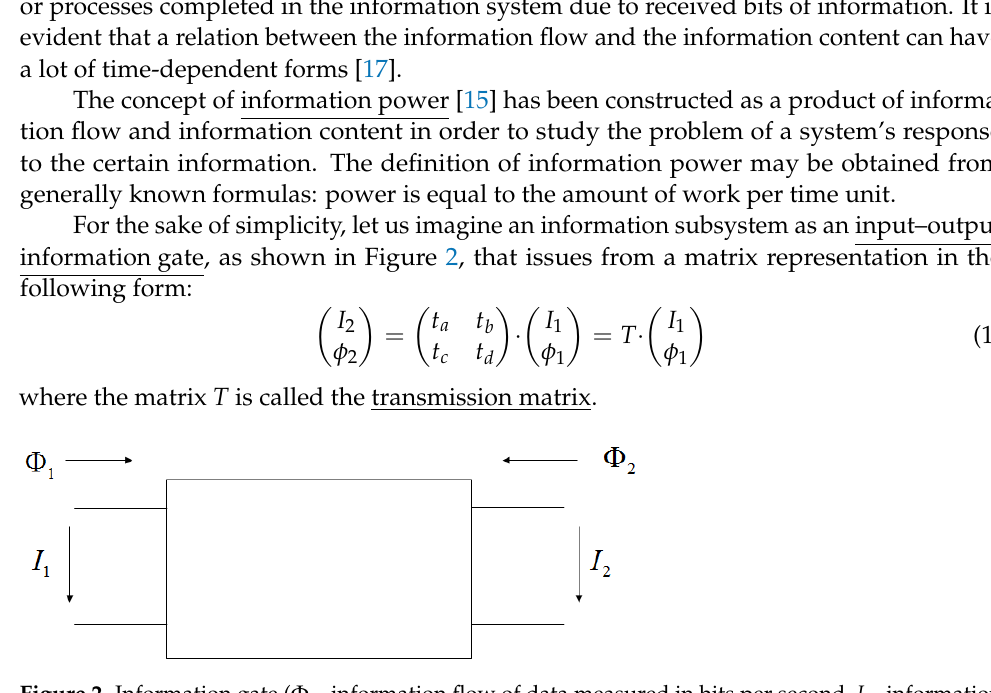
Figure 2. Information gate ( Φ —information flow of data measured in bits per second, I —information content measured in Joules per bit).